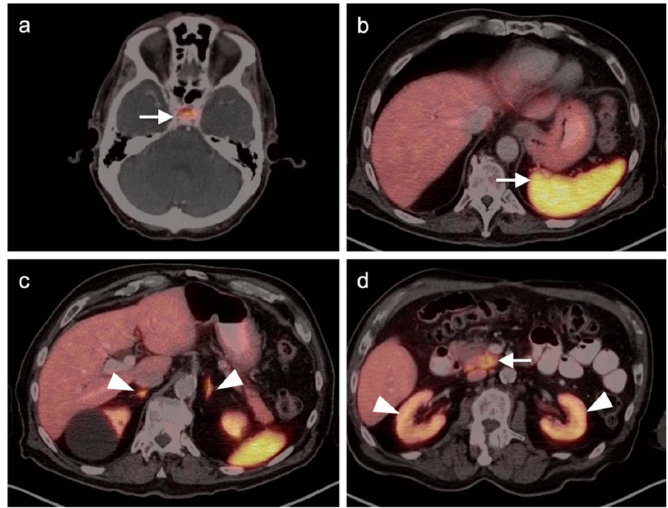
Figure 37. Normal biodistribution of [ 68 Ga]Ga-DOTA-TATE (NETSPOT ® ) PET-CT. ( a ) Normal uptake in the pituitary gland on an axial PET-CT image of the head (white arrow). ( b ) Normal intense uptake in the spleen on an axial PET-CT image of the upper abdomen (white arrow). ( c ) Normal uptake in the adrenal glands on an axial PET-CT image of the abdomen (white arrowheads) (note incidental right renal cyst). ( d ) Normal uptake on an axial PET-CT image of the abdomen in the uncinate process of the pancreas (white arrow) and in the kidneys (white arrowheads). A similar biodistribution is also seen with [ 64 Cu]Cu-DOTA-TATE (Detectnet ®